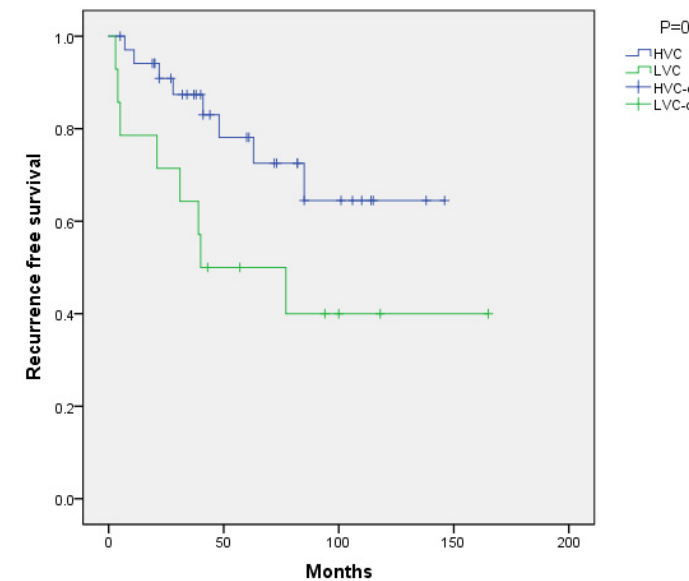
Figure 1. Recurrence free